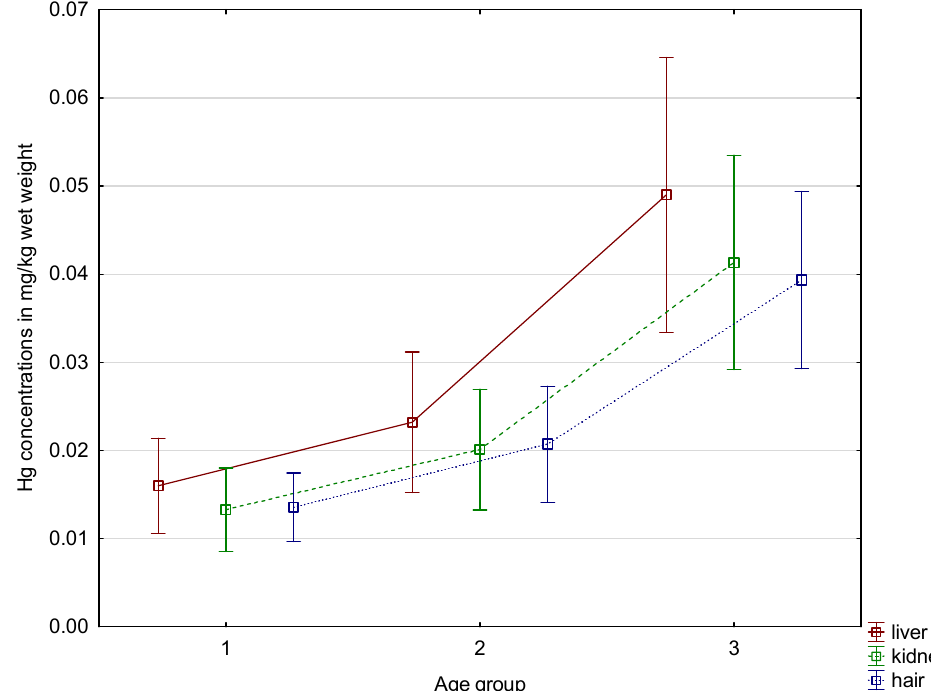
Figure 1. Mercury contents depending on age group: 1—cats (1–5 years); 2—cats (6–10 years); 3—cats (11–15 years).